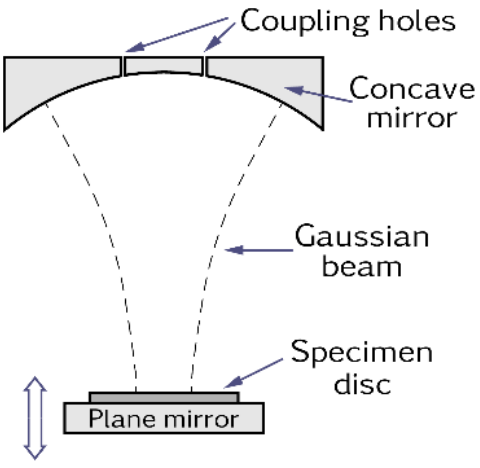
Figure 1. Fabry-Perot open resonator used for MW measurements.